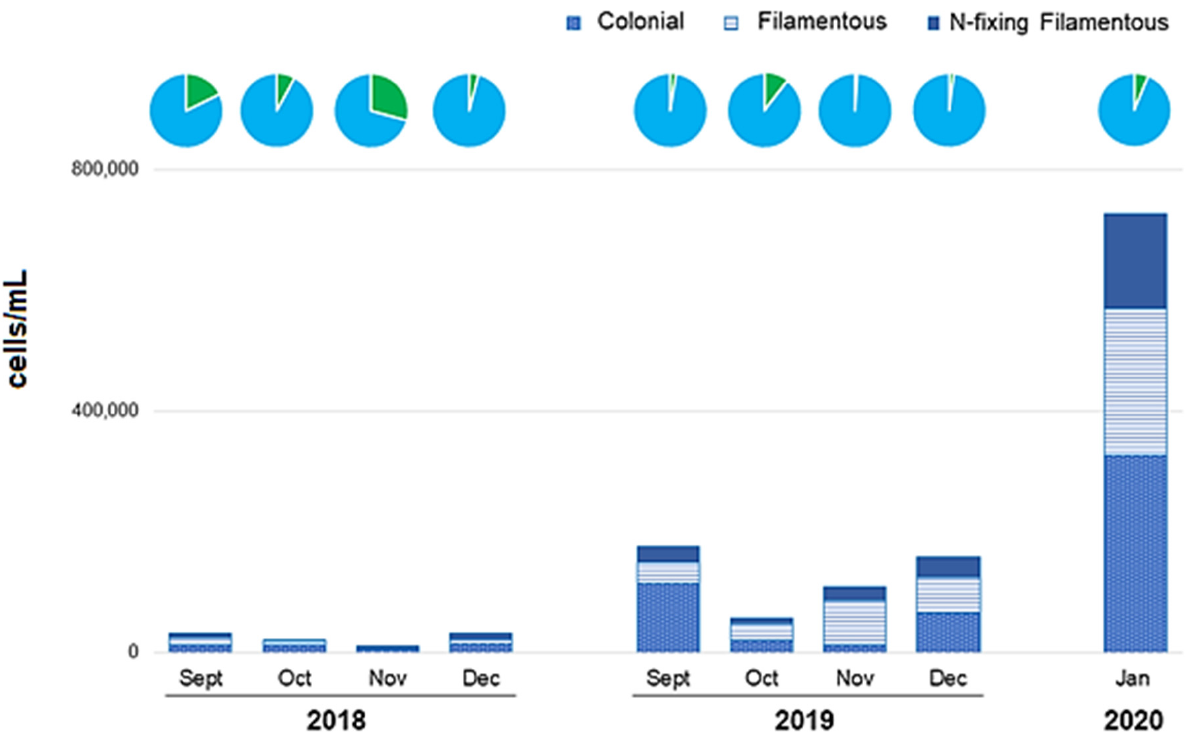
Figure 4. Morphotypes of cyanobacteria by year. The proportions of cyanobacteria among total phy- toplankton are shown as pie charts above (in blue); the other phytoplankton groups are represented in green.